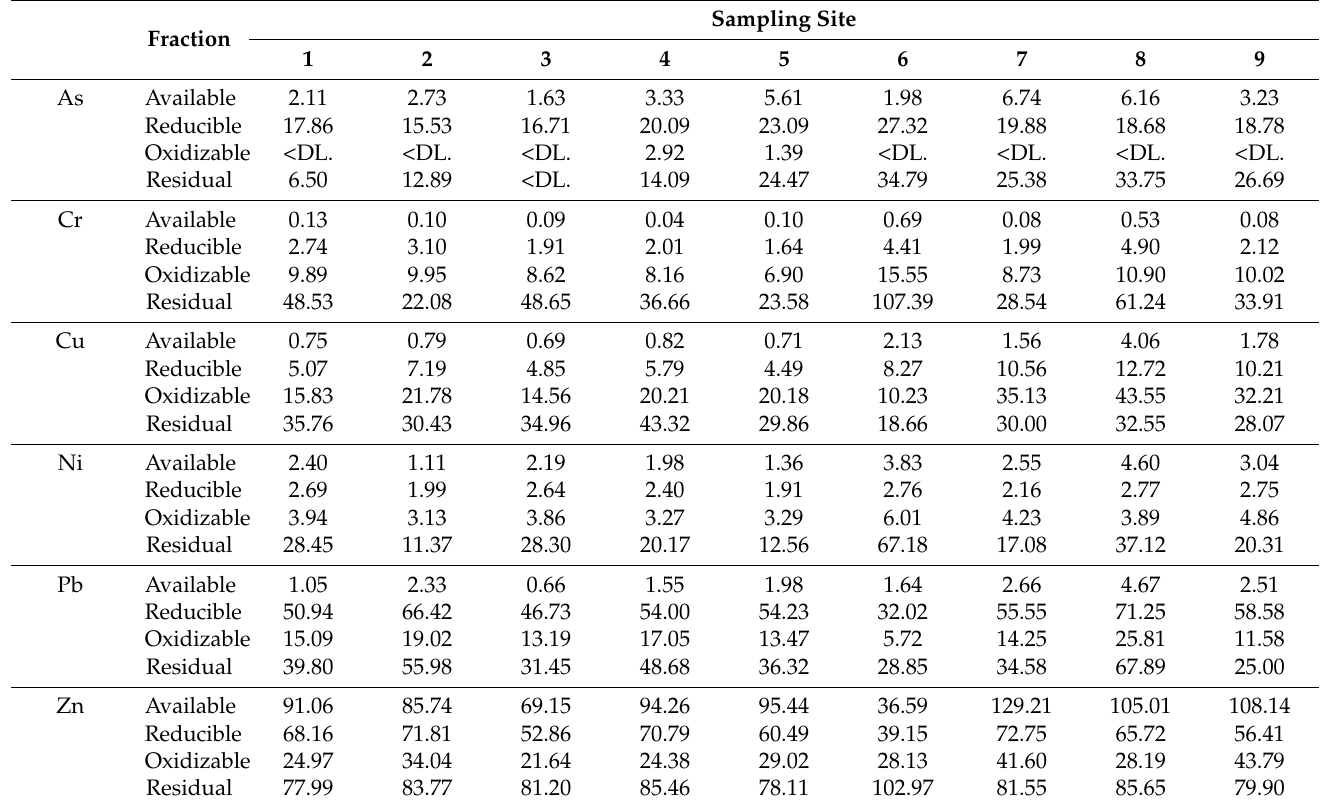
Table 3. Means of As and metal contents ( µ g g − 1 ) for each sampling site, extracted from each step of sequential extraction of the bottom sediments from the Terragido reservoir (fraction ≤ 63 µ m) (DL.: detection limit).